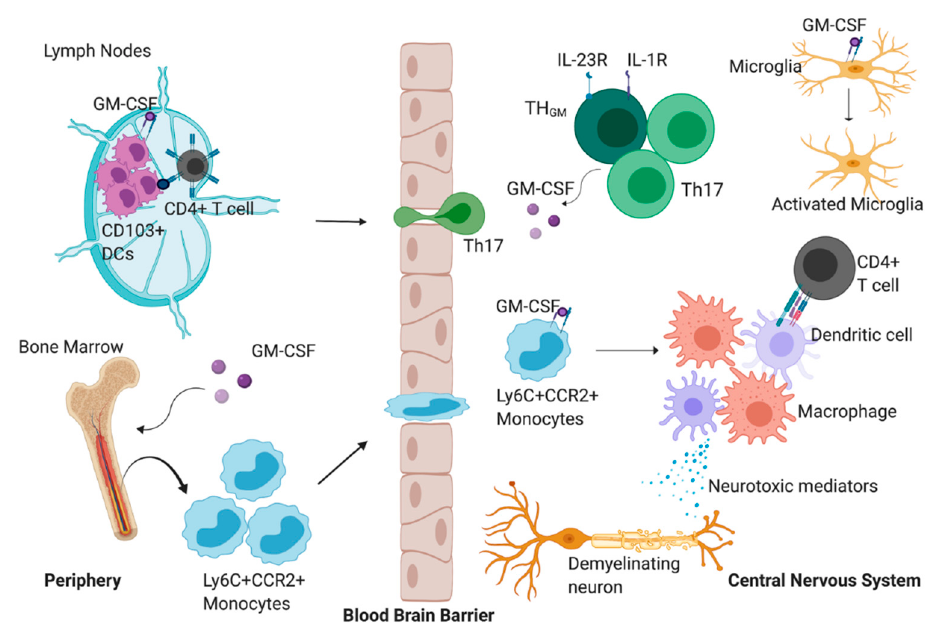
Figure 1. The proposed role of granulocyte-macrophage colony-stimulating factor (GM-CSF) during experimental autoimmune encephalomyelitis (EAE). GM-CSF promotes the accumulation of CD103+ dendritic cells (DCs) in the lymph nodes which can present myelin antigen to CD4+ T cells. These CD4+ T cells can then migrate into the central nervous system (CNS) parenchyma where they begin to produce GM-CSF exclusively, or GM-CSF and IL-17. GM-CSF production by the CD4+ T cells promotes the migration of Ly6C+CCR2+ cells from the bone marrow to the CNS. Once in the CNS, GM-CSF signaling promotes the differentiation of monocytes into a heterogenous population of monocyte-derived macrophages and monocyte derived dendritic cells. Monocyte-derived dendritic cells can interact with and promote the activation of infiltrating CD4+ T cells. In addition, these differentiated cells can secrete mediators that directly promote demyelination, tissue damage and axonal loss. GM-CSF can also promote the activation of CNS-resident microglia. These reactive microglia can potentiate the inflammatory milieu by producing proinflammatory mediators.